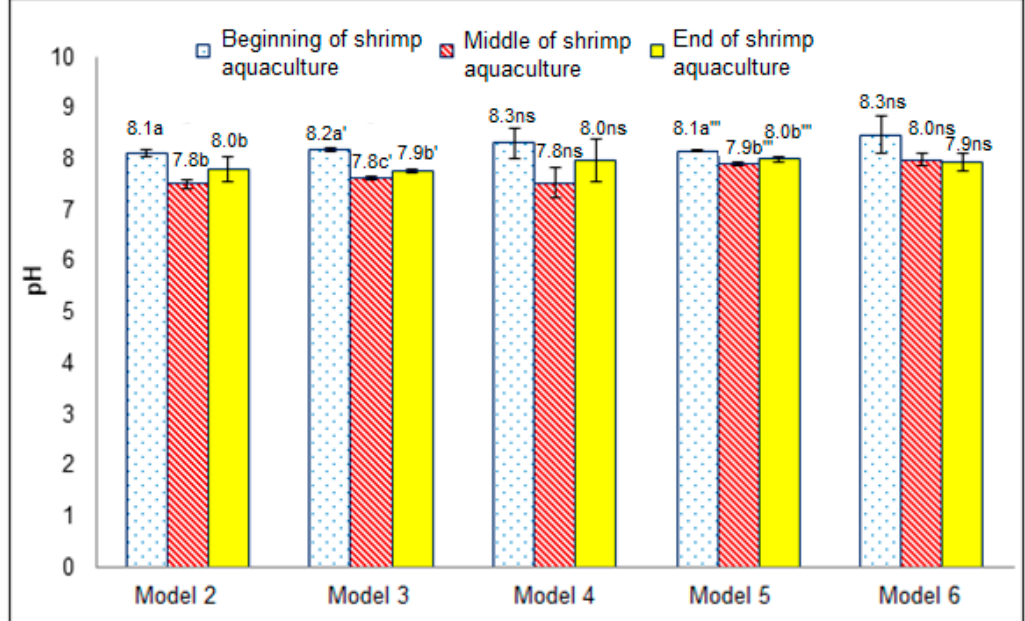
Figure 2. Variations of pH of water in examined farming systems. Notes: a and b are compared according to sampling time, the same letters within the same column or row have no significant difference. The symbols ‘, ‘’’ are used to distinguish different experimental or model areas. ns: no difference (compared at a significance level of 5%).